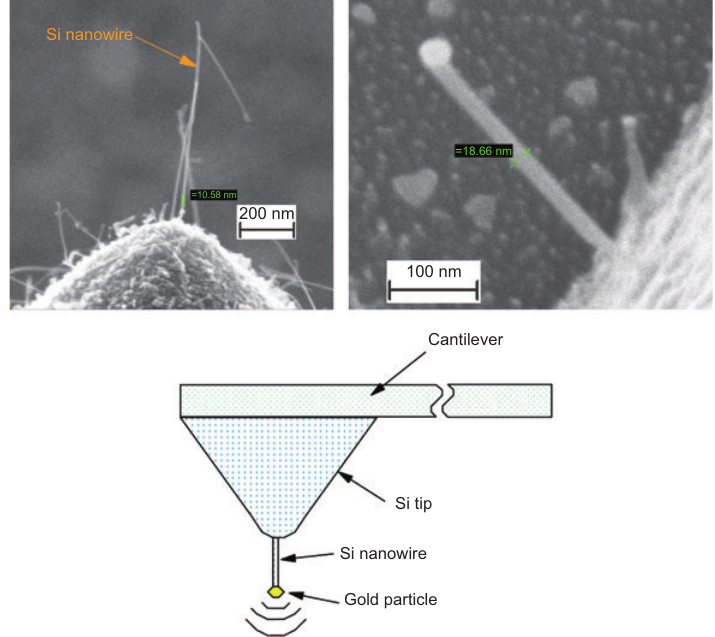
Figure 15 Gold nanosphere at the tip of a Si nanowire after epitaxial tip growth. Images courtesy of G. Cohen, IBM T.J. Watson Center, Yorktown Heights, NY, USA [131]